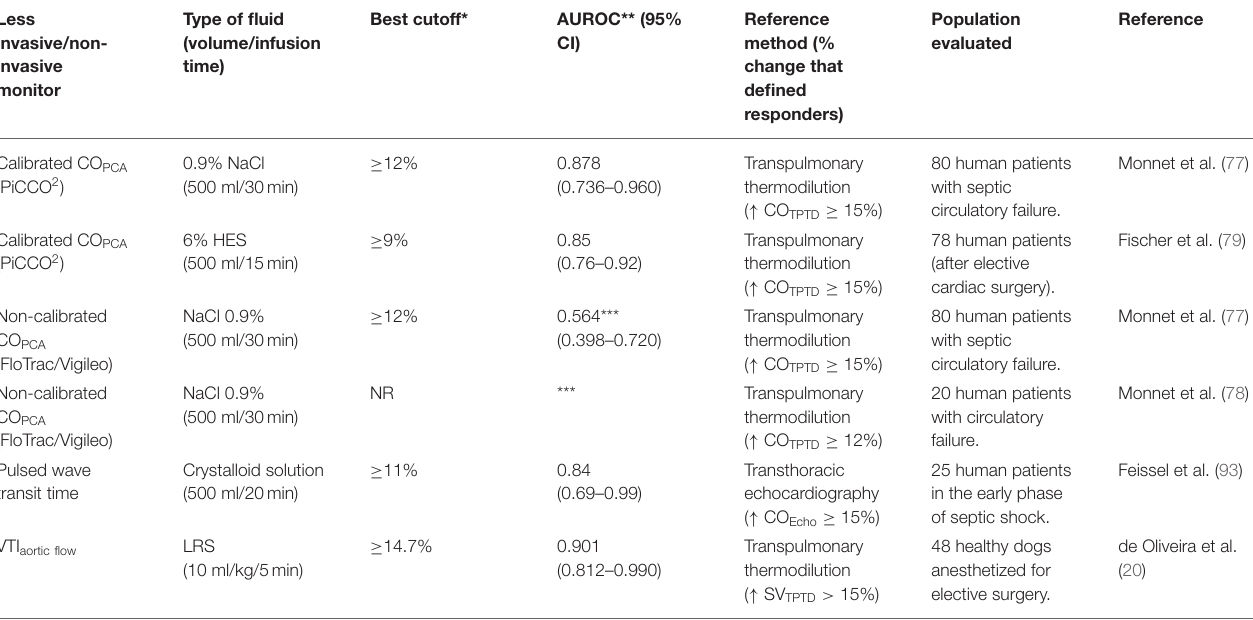
TABLE 4 | Ability of less invasive/non-invasive methods of cardiac output and stroke volume monitoring to discriminate responders from non-responders to volume expansion induced by a fluid challenge. Less